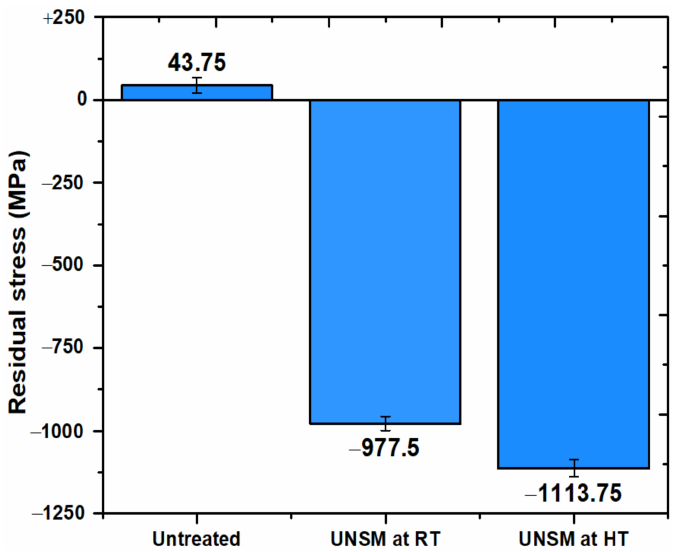
Figure 6. Comparison in residual stress of the untreated, UNSM-treated at RT and HT